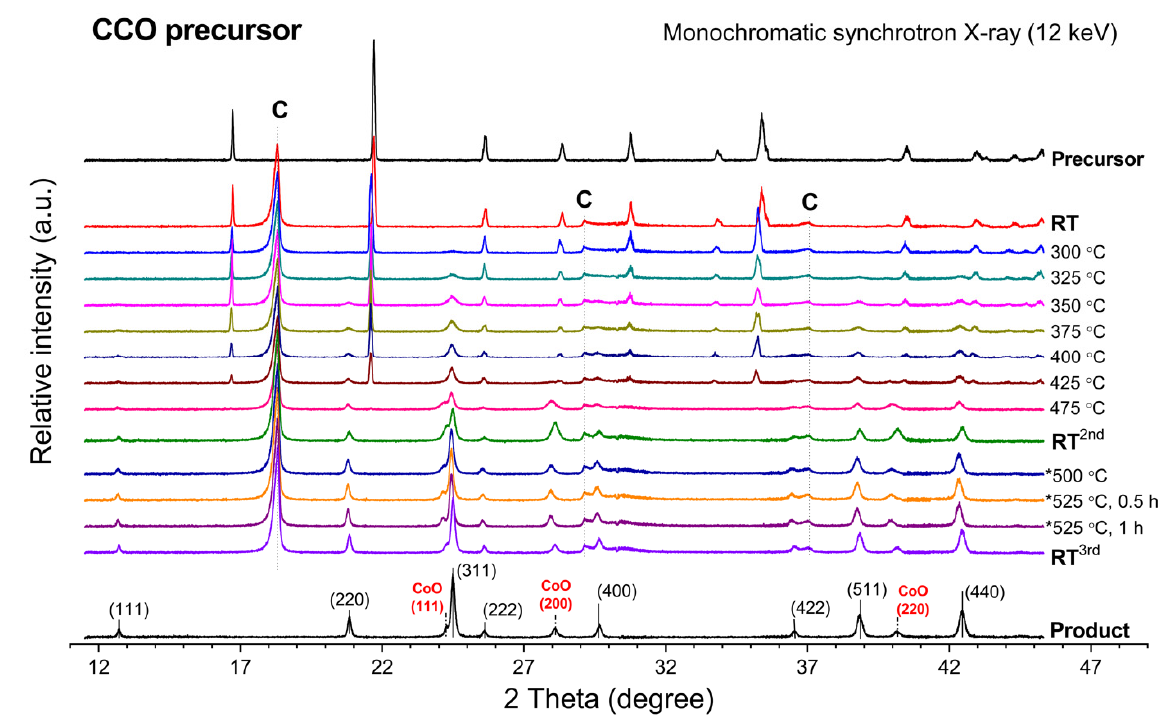
Figure 1. In-situ XRD profile representing phase transformation of the CCO precursor upon an elevating calcination temperature. (C = graphite dome, * = 2nd calcination cycle).